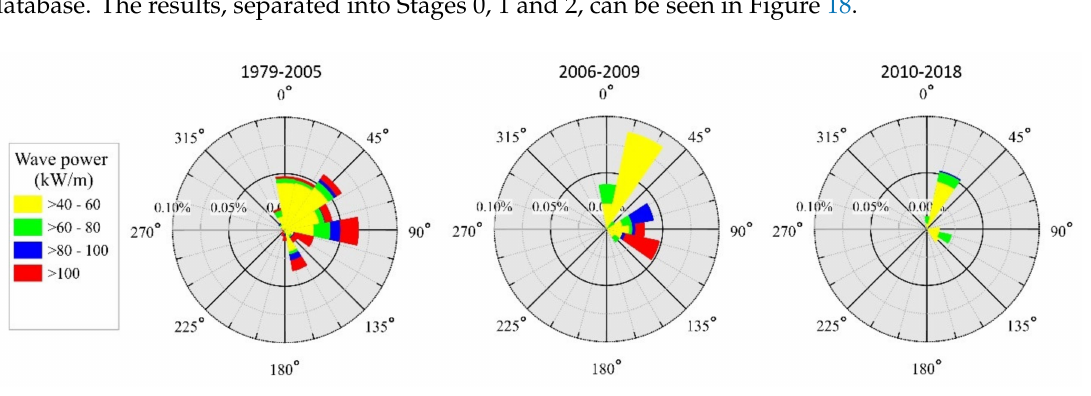
Figure 18. Distribution of the wave power according to incident direction. Stage 0 (1979–2005); Stage